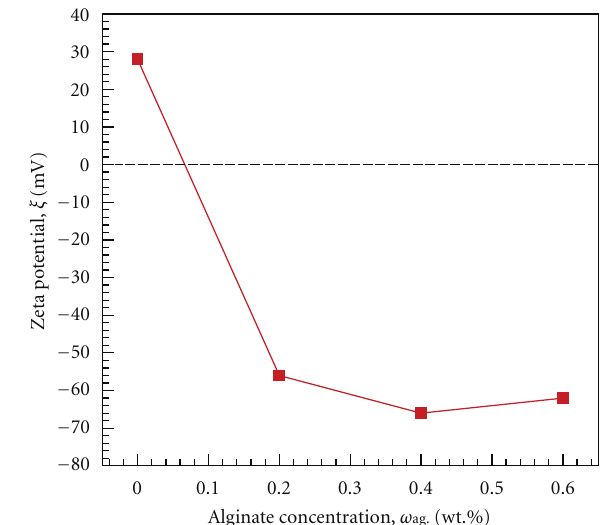
Figure 3: The zeta potential for the 1.0 wt.% TiO 2 nanoparticles suspended in base liquid.